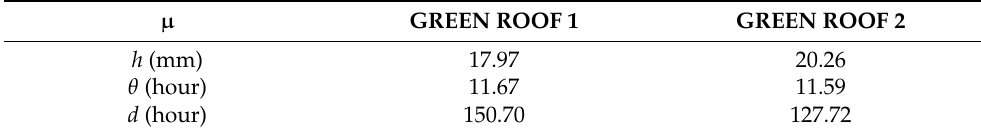
Table 1. Average values of rainfall variables.